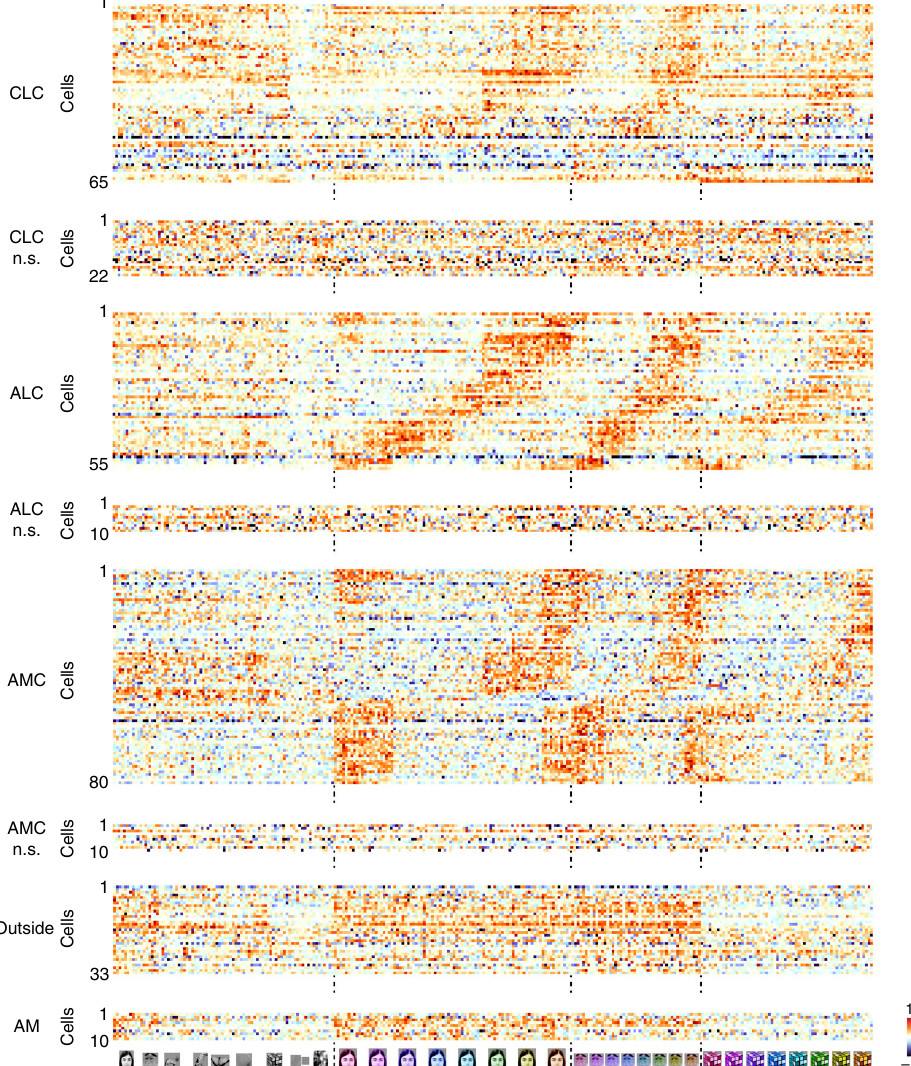
Fig. 2 Responses of color-patch neurons to the color stimuli. Responses of all neurons in three patches to all grayscale images, colored human faces, monkey faces, and magic cubes, sorted according to hue preference of the average response across all 82 stimuli. Color-selective cells and non-selective cells are shown separately. Responses of IT cells outside color patches and cells in face patch AM are also shown. For each cell, baseline was subtracted and the response was